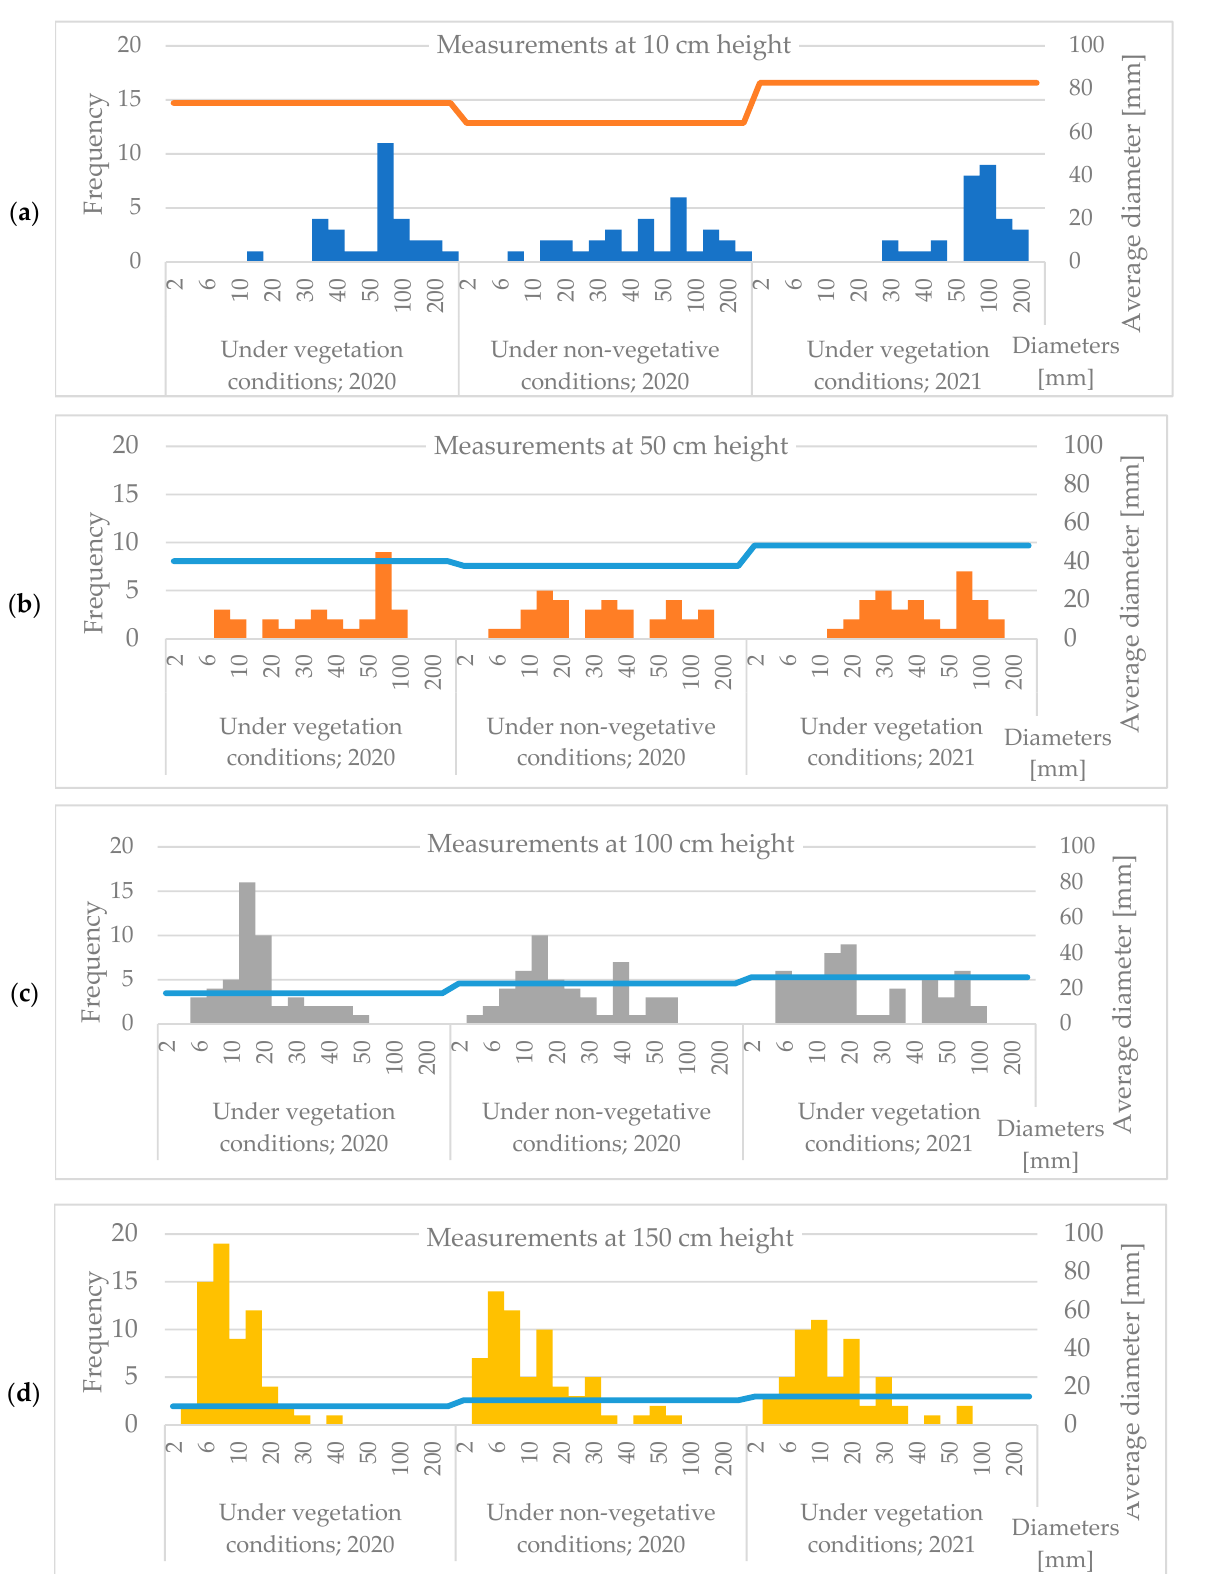
Figure 8. Histograms of No. 3 bush diameters. Measurements were taken at heights of ( a ) 10 cm, ( b ) 50 cm, ( c ) 100 cm, and ( d ) 150 cm above the ground. Table 1. Summary of the results of the series of measurements of the branches diameters of shrub No. 1.